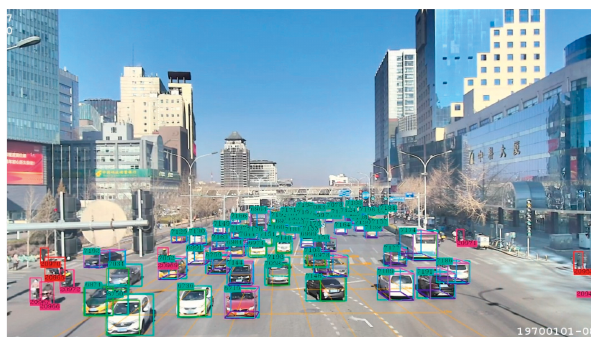
Figure 13: Tracking result of camera. Incident detection performance for long road scenario in